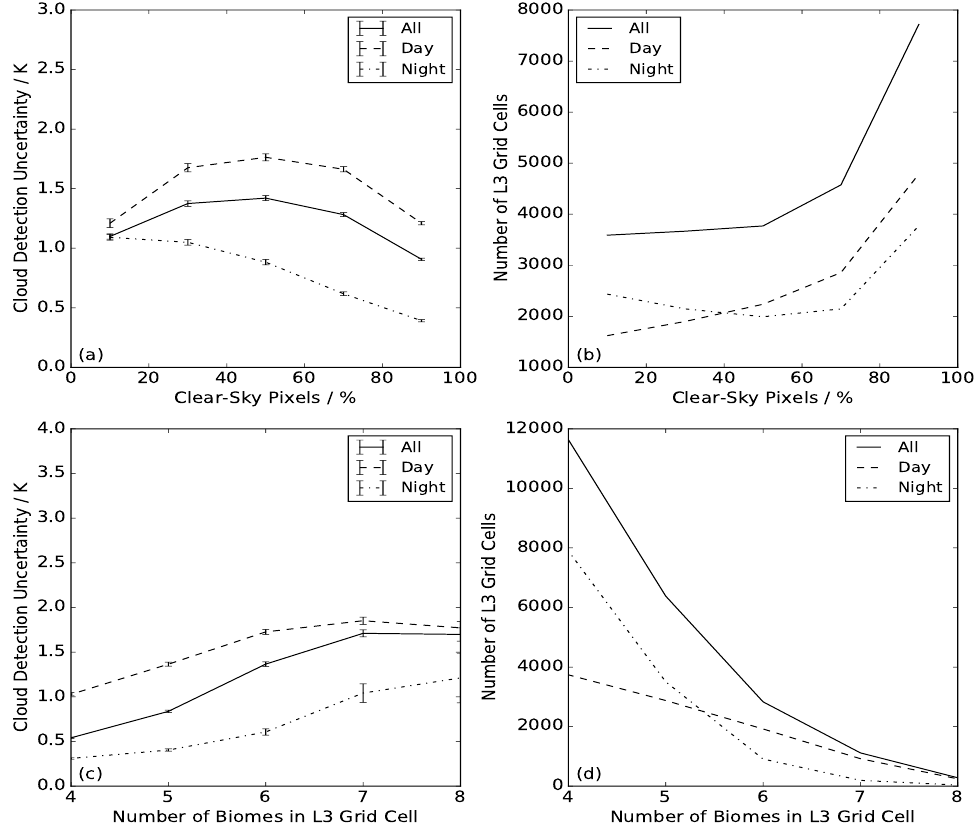
8 Number of Biomes in L3 Grid Figure 11. Cloud detection uncertainties as a function of clear-sky fraction ( a ) and number of biomes ( c ) at 25-km 2 resolution. Right-hand panels show the number of observations in each clear-sky bin ( b ) and for each number of biomes represented in a given grid cell ( d ). The following are shown: all data (solid line), night-time only (dot-dash line) and daytime only (dashed